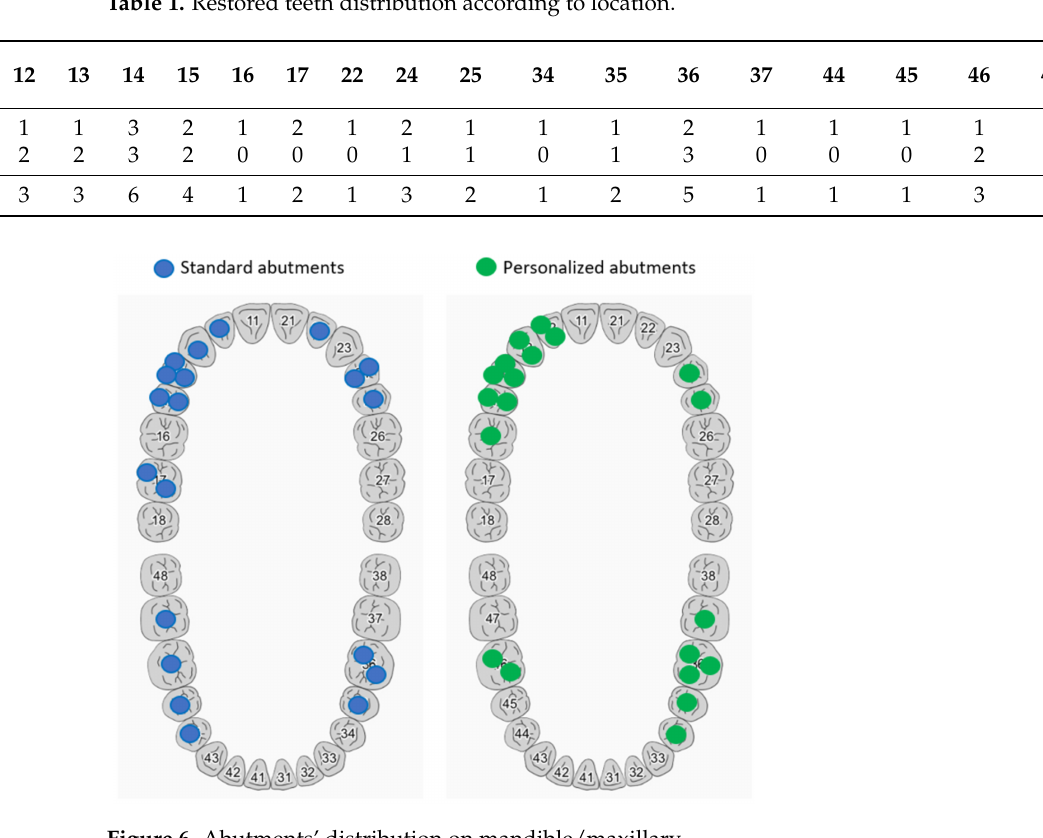
Figure 5. Example of customized prosthetic abutments milled into disc by Titanium Magnum Hyperone: ( a ) aspect after milling; ( b ) aspect after removal from the disc. Distribution of teeth restored with implant restorations is emphasized in Table 1 and Figure 6. Table 1. Restored teeth distribution according to location.